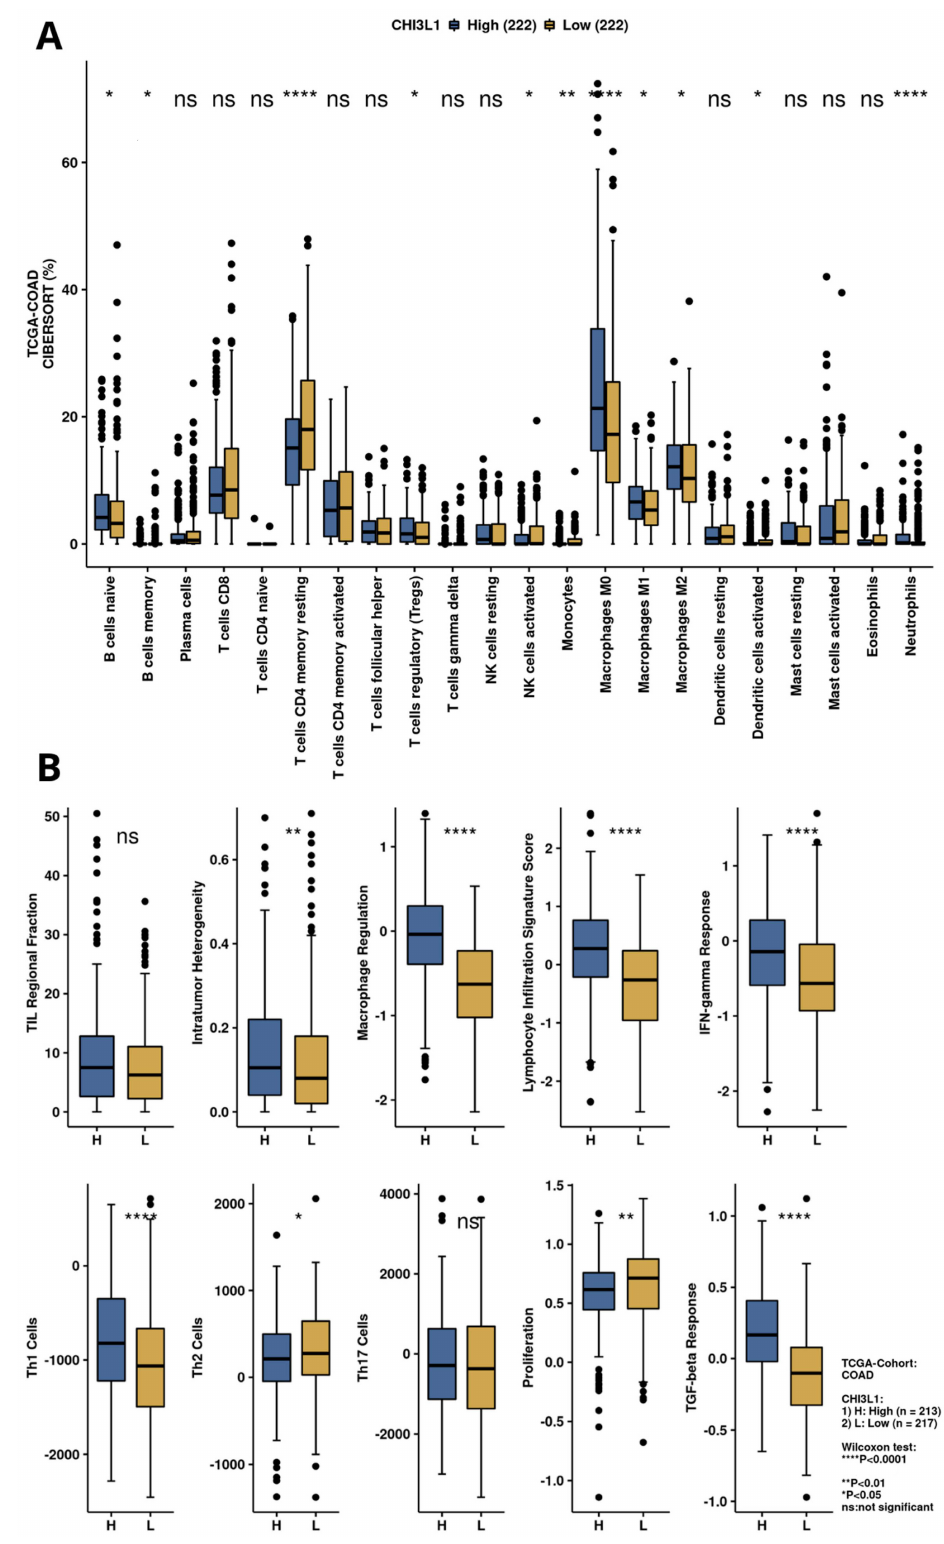
Figure 4. Immune infiltration and immunogenicity analysis for YKL-40 (CHI3L1) based on TCGA- COAD data. ( A ) Infiltration of immune cells for CHI3L1 expression groups calculated by CIBERSORT algorithm. ( B ) Immune-related scores for high and low CHI3L1 expression